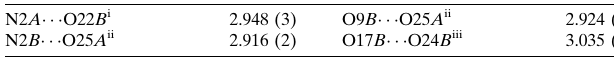
Selected interatomic distances (A˚ ).